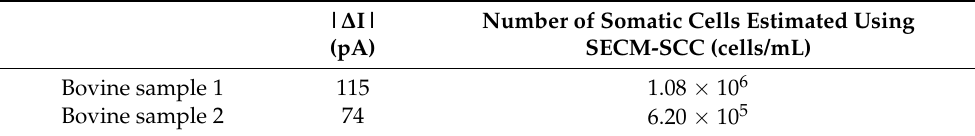
Figure 12. Comparison of respiration activity between bovines diagnosed with different stages of mastitis. I N : relative value of oxygen reduction current in bulk, which was set at 0 nA. Table 3. Comparison of bovines by SECM-SCC. The number of somatic cells was estimated from Figure 10.